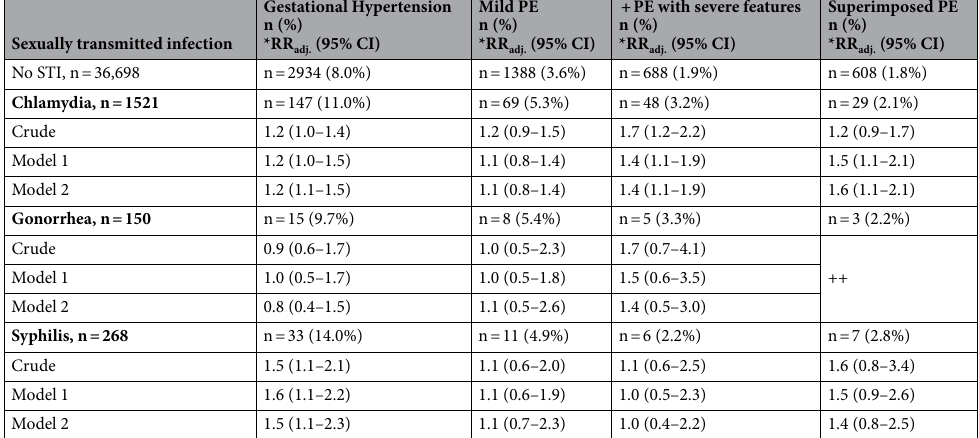
Table 2. Sexually transmitted infections (STI) and hypertensive disorders of pregnancy. *Model 1: Adjusted for insurance type, maternal age, race/ethnicity, and education. *Model 2: Fully adjusted model included all variables in model 1 plus smoking, substance use and co-infection with other STIs. + Preeclampsia with severe features as defined by American College of Obstetricians and Gynecologists guidelines.